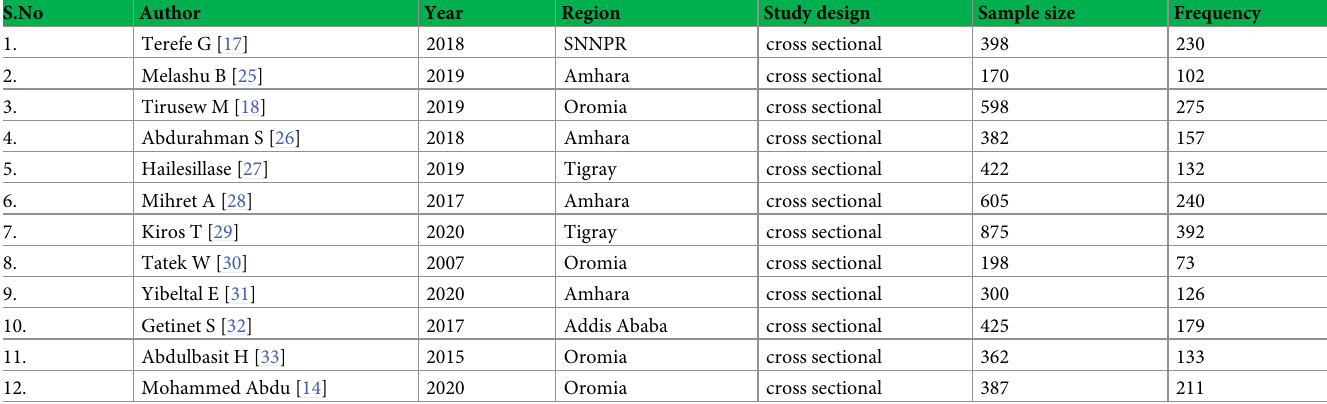
Table 1. Characteristics of the included studies on treatment seeking delay in Ethiopia,